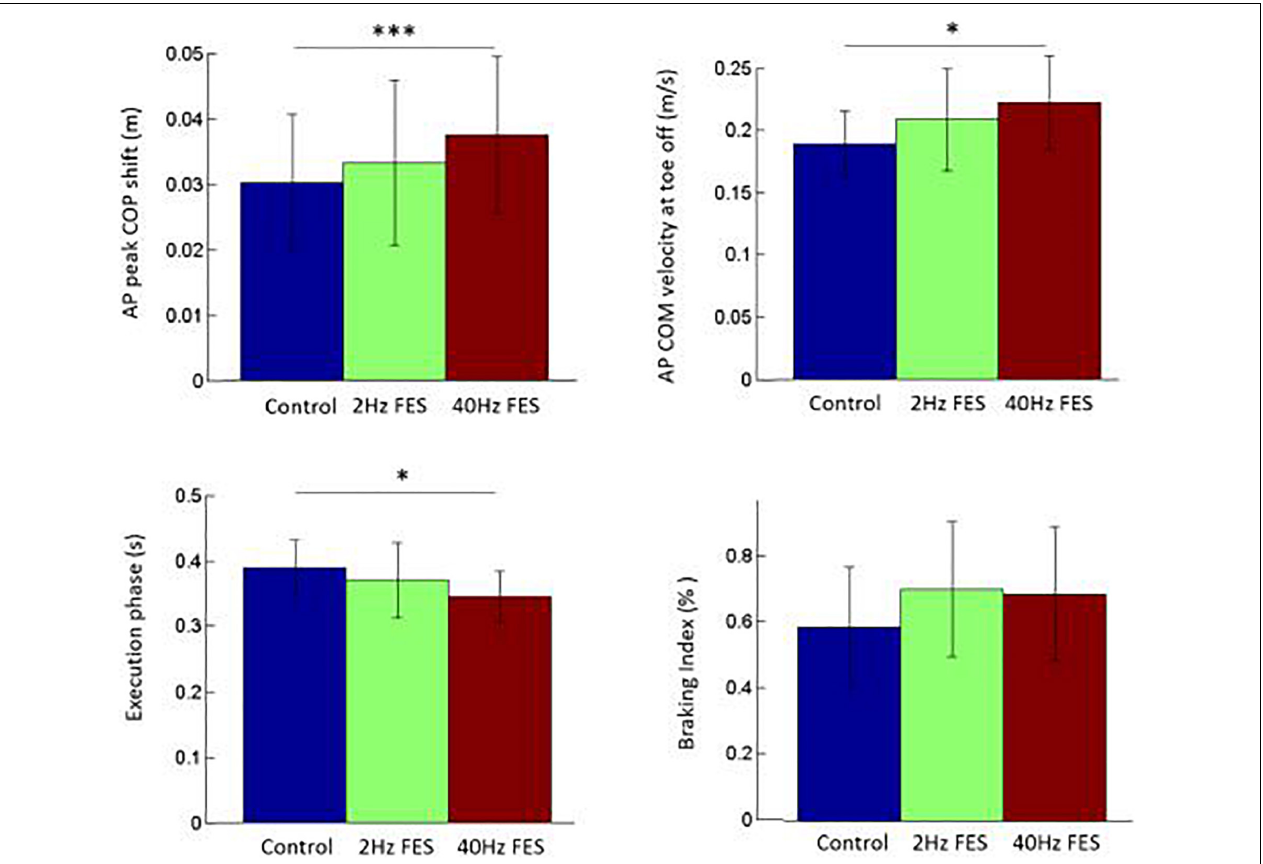
FIGURE 2 | Comparison of selected gait initiation parameters between the three conditions. Reported are mean values (all participants together) ± 1 SD. AP: anteroposterior direction. COM, COP: center of mass, center of pressure, respectively. ∗ , ∗∗∗ indicates a significant difference between bars with p < 0.05 and p < 0.001 as revealed with the post hoc